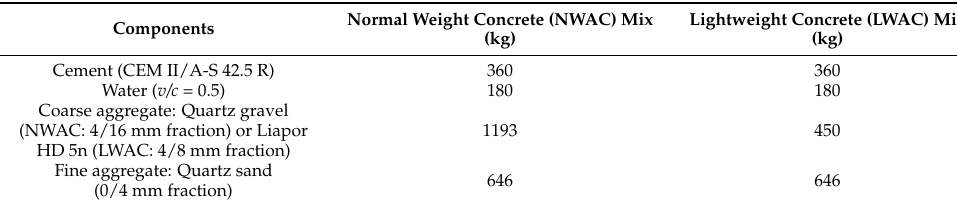
Table 2. Composition of (1 m 3 ) mixes.